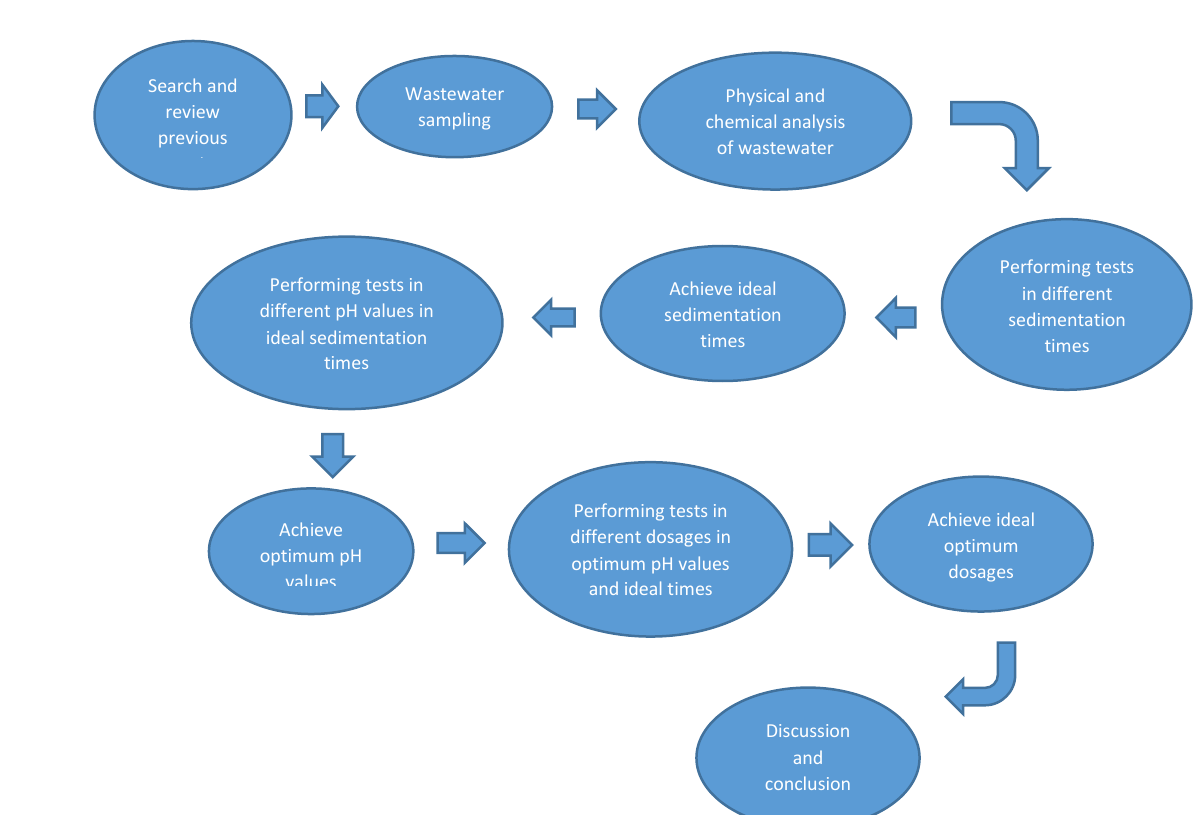
Figure 1. Schematic diagram of the study proces Fig. 1. Schematic diagram of the study process